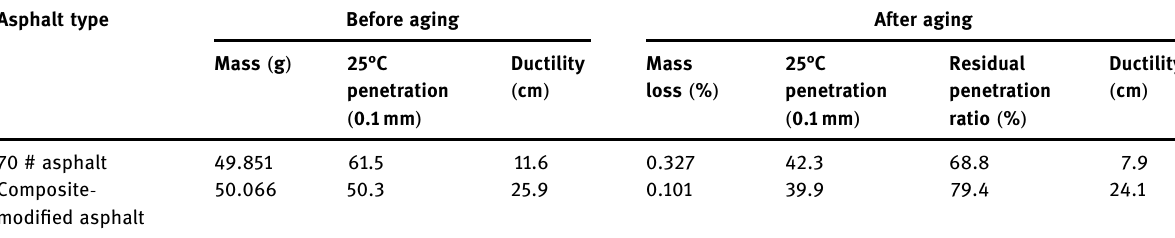
Table 7: Short - term aging test results of modi fi ed asphalt Asphalt type